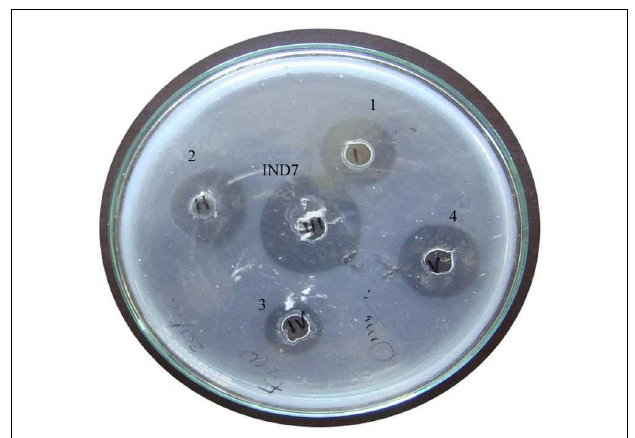
FIGURE 1 | Fibrinolytic activity of enzyme from the bacterial